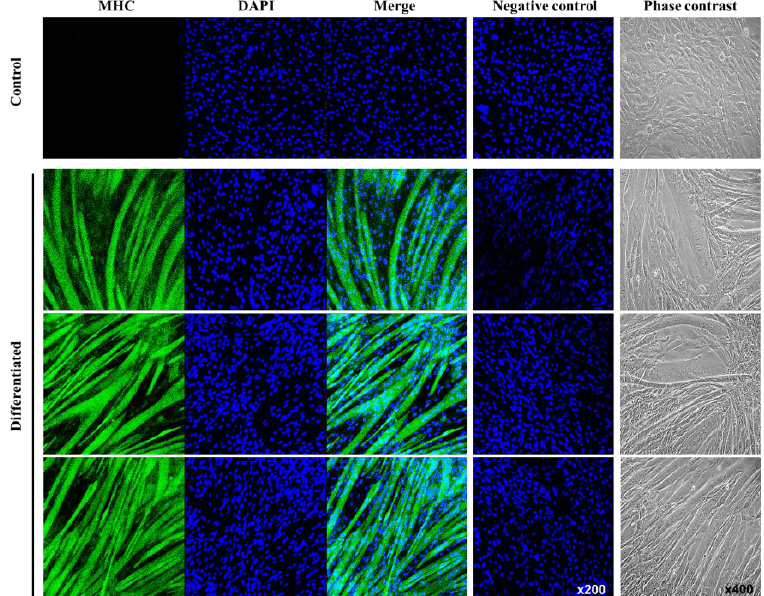
Figure 5. Changes in the morphology and MHC expression in myotubes differentiated from C2C12 myoblasts. MHC expression was detected by staining with an anti-MHC antibody ( Green ), while nuclei were detected by DAPI staining ( Blue ).